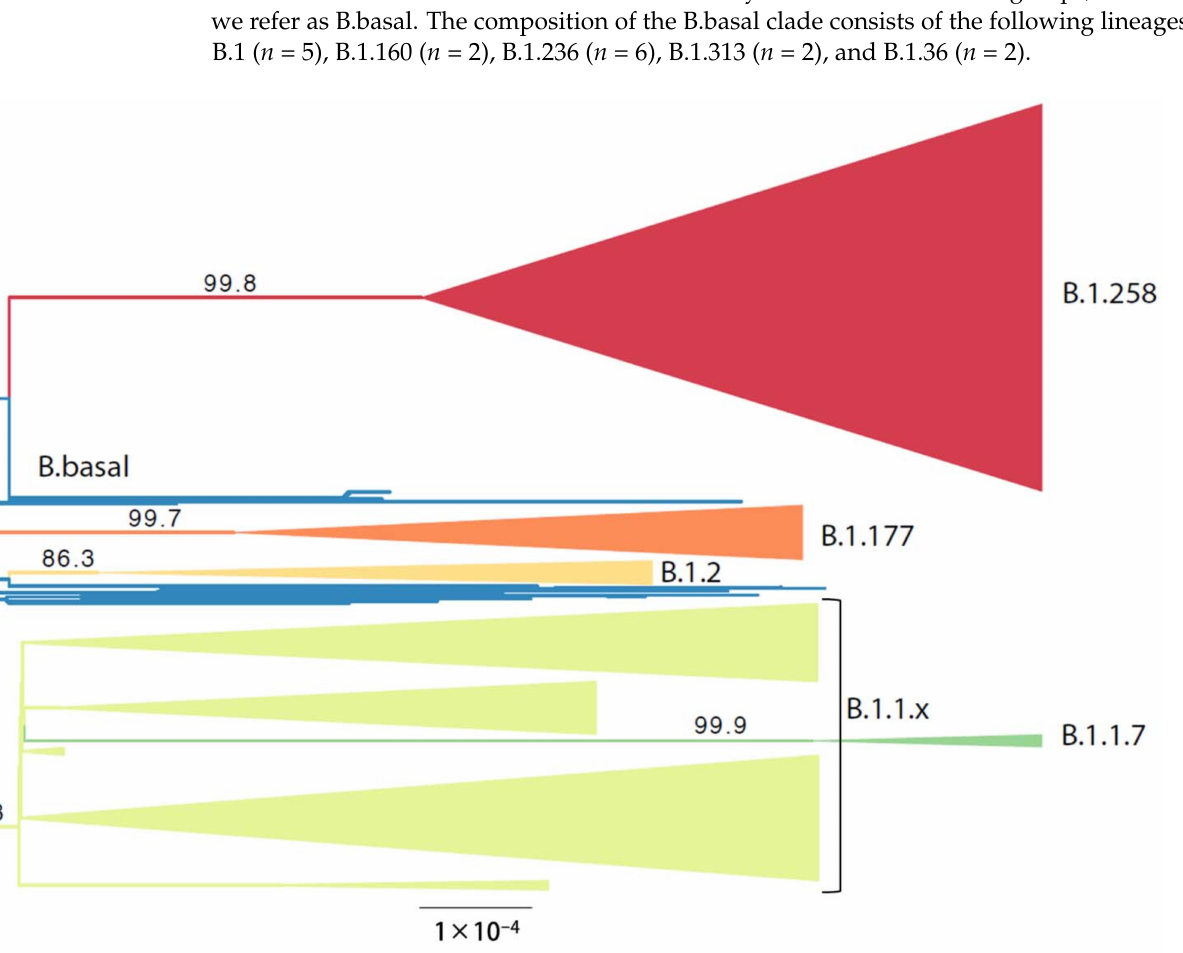
Figure 4. The maximum likelihood phylogeny used to delineate lineage-specific subsets among the newly generated Cypriot SARS-CoV-2 complete genomes. The tree is midpoint rooted. Branch support values are indicated next to the relevant branches. The B.1.258 clade is represented by red, the B.basal clade by blue, the B.1.177 clade by orange, the B.1.1.x clade by light green and the B.1.1.7 clade by green. The scale is provided by the black bar below the tree in substitutions per